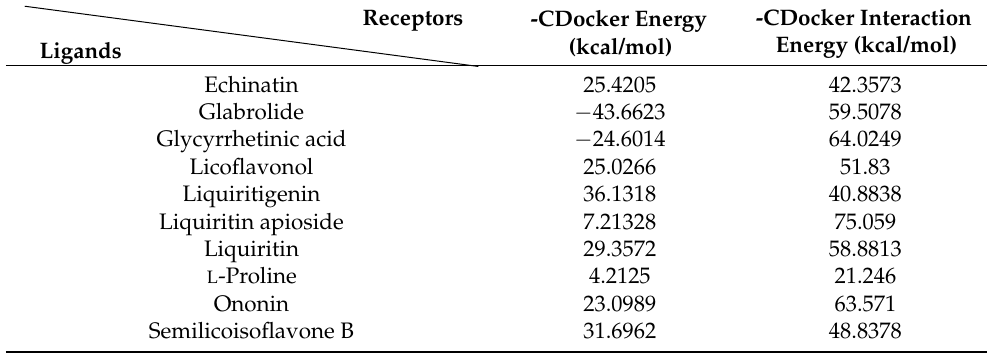
Table 2. Docking energies for optimal conformation of main components of roasted licorice with respect to